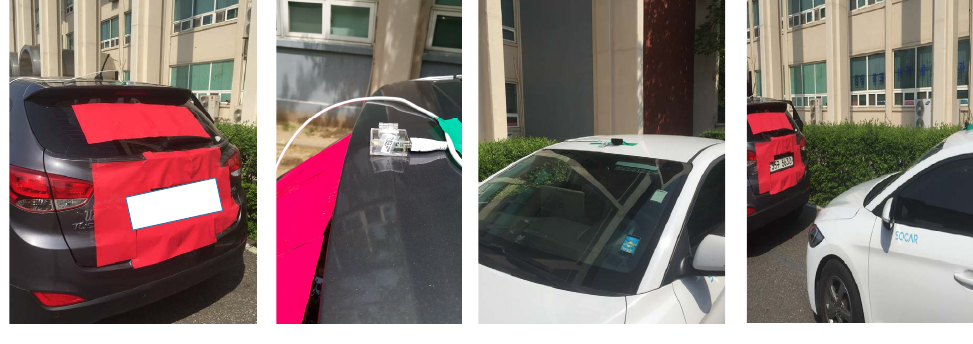
Figure 4. Testbed scenes.